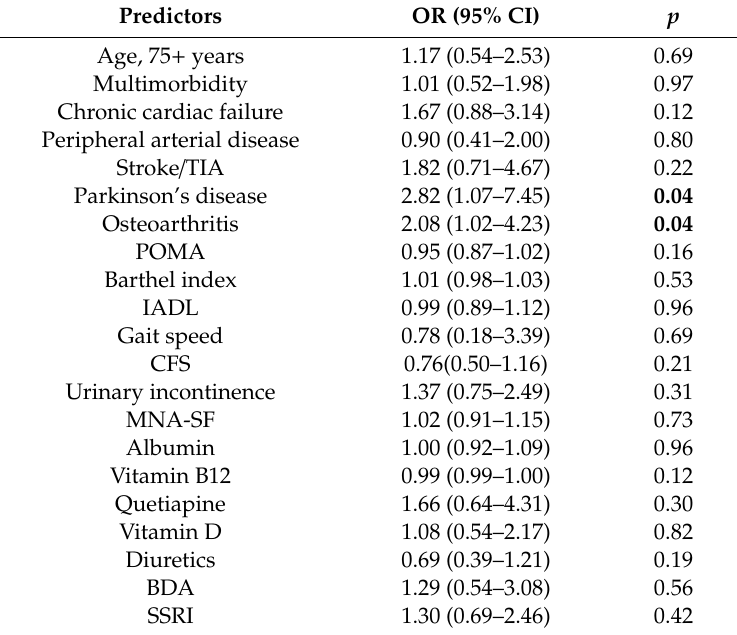
Table 3. Results of the direct logistic regression model indicating characteristics associated with falls.